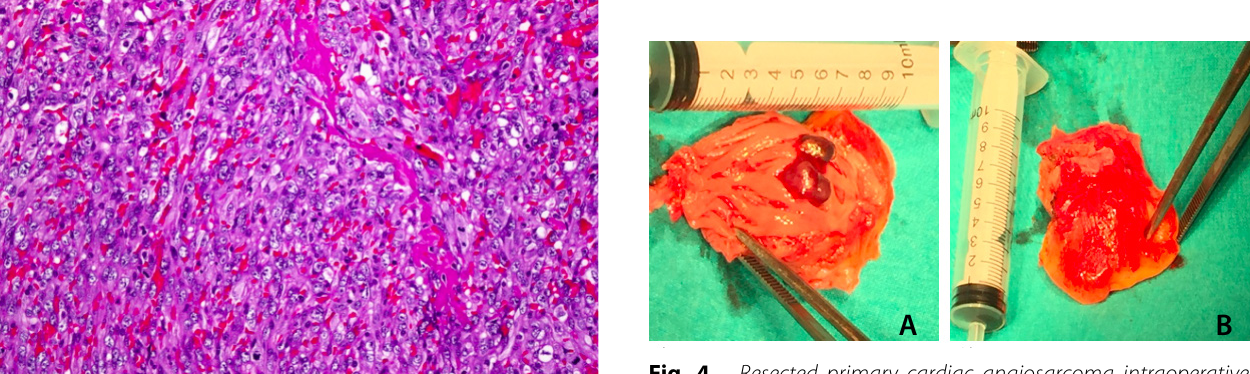
Fig. 4 – Resected primary cardiac angiosarcoma intraoperative images. A) inferior wall of right atrium reveals with 3x3 cm tumoral mass, B) outer surface of the right atrial wall with stuck